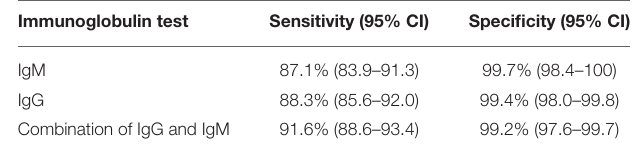
TABLE 1 | Severe acute respiratory syndrome-related coronavirus 2 (SARS-CoV-2) real-time quantitative PCR (RT-qPCR) test results. ORF1ab